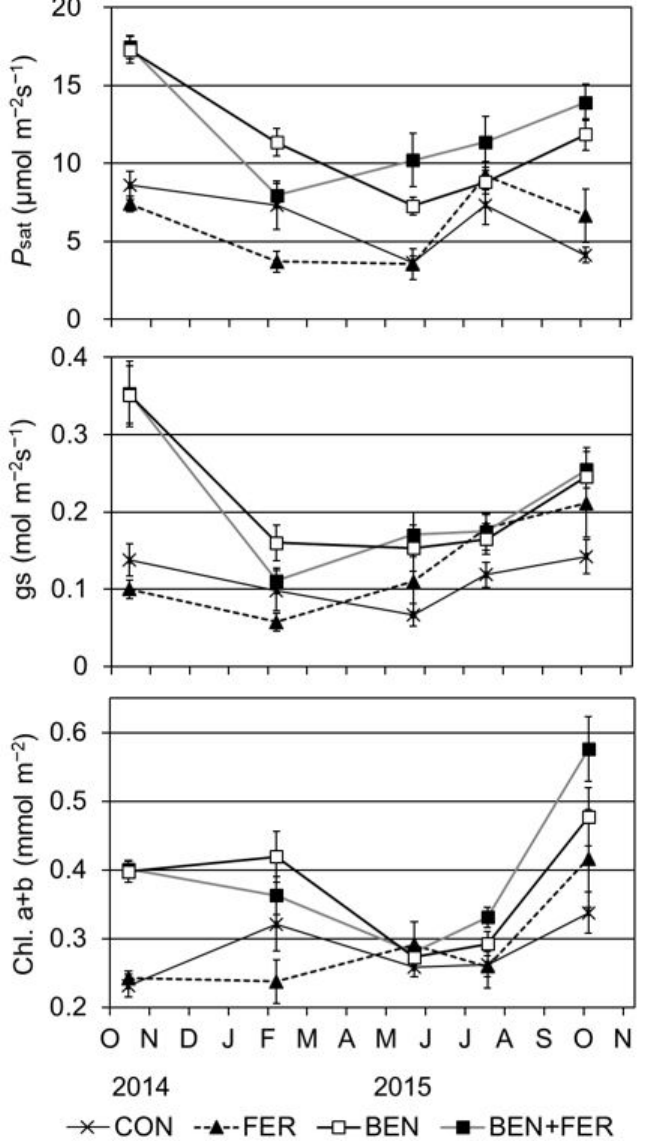
Figure 3. Photosynthetic rate at light saturation ( P sat ), stomatal conductance (gs), and concentration of chlorophyll ( a + b ) in teak seedlings grown in the four treatments (9:00–11:00, mean ± SE, n = 9). Note. n = 6 in the FER. and BEN + FER treatments from May 2015 because of dead